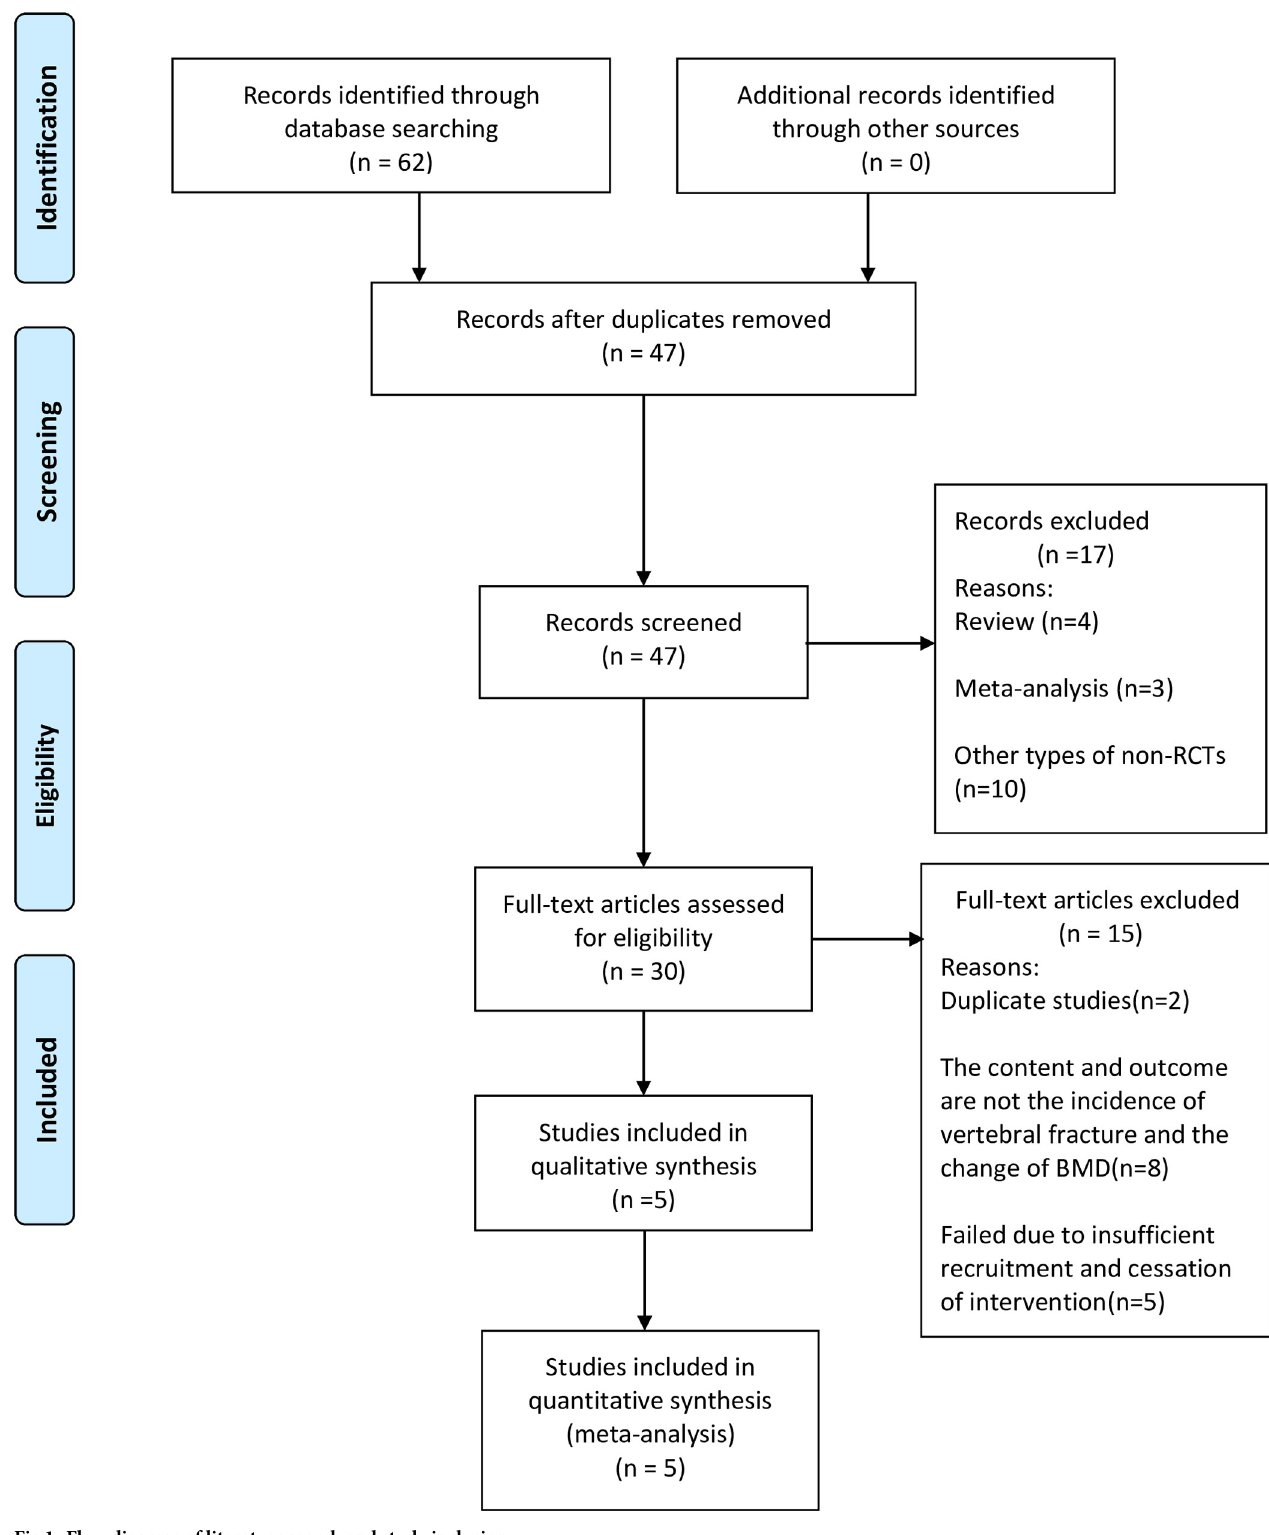
Fig 1. Flow diagram of literature search and study inclusion.